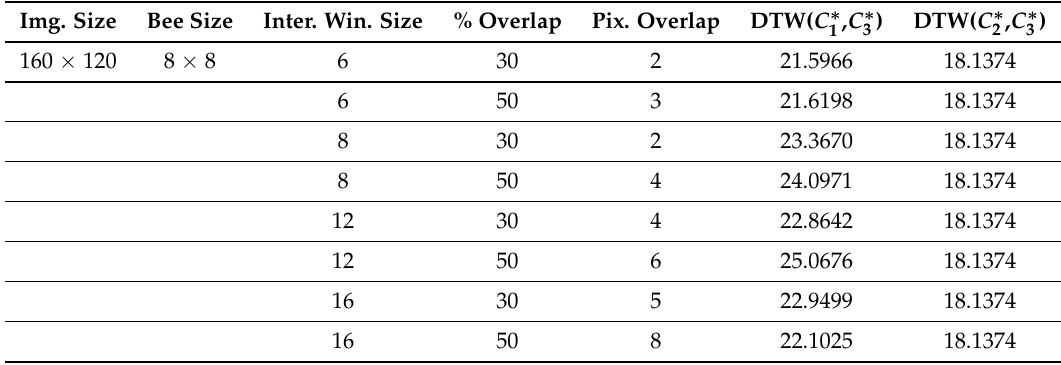
Table A14. DTW values for LT _ Vid . mp 4 with image size of 160 × 120; C ∗ and C ∗ is Human Count (ground truth). 3